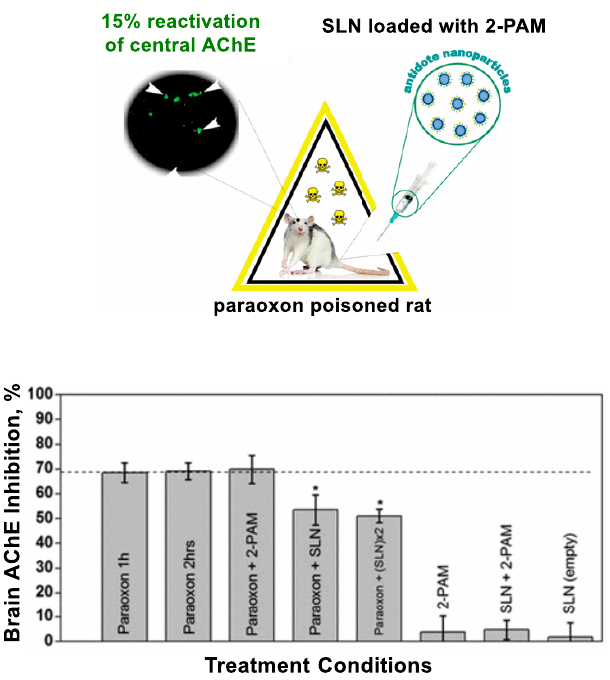
Figure 5. CNS drug delivery using 2-PAM-loaded solid lipid nanoparticles (SLN). This treatment shows a higher level of acetylcholinesterase (AChE) reactivation (lower inhibition) in paraoxon- poisoned rats. * statistical significance of p < 0.05 relative to a control (paraoxon alone). Adapted with permission from [91], Copyright 2017, American Chemical Society.